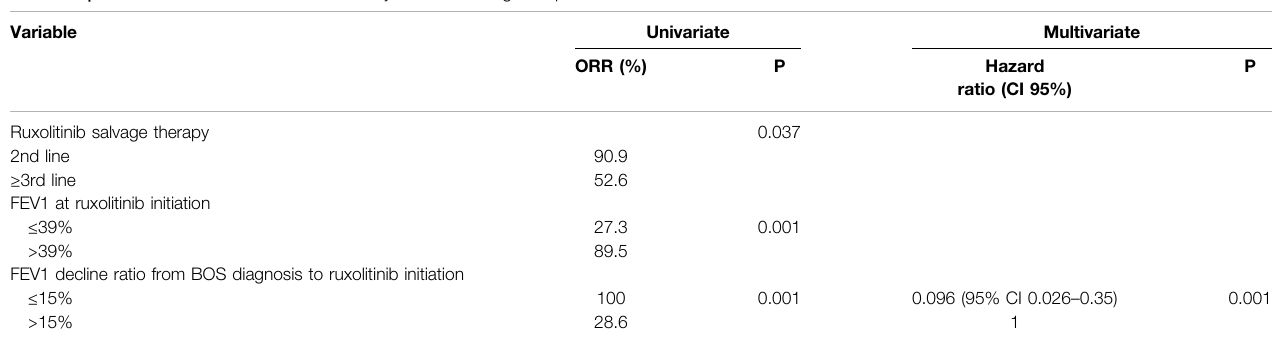
TABLE 2 | Clinical univariate and multivariate analysis for achieving a response to ruxolitinib.